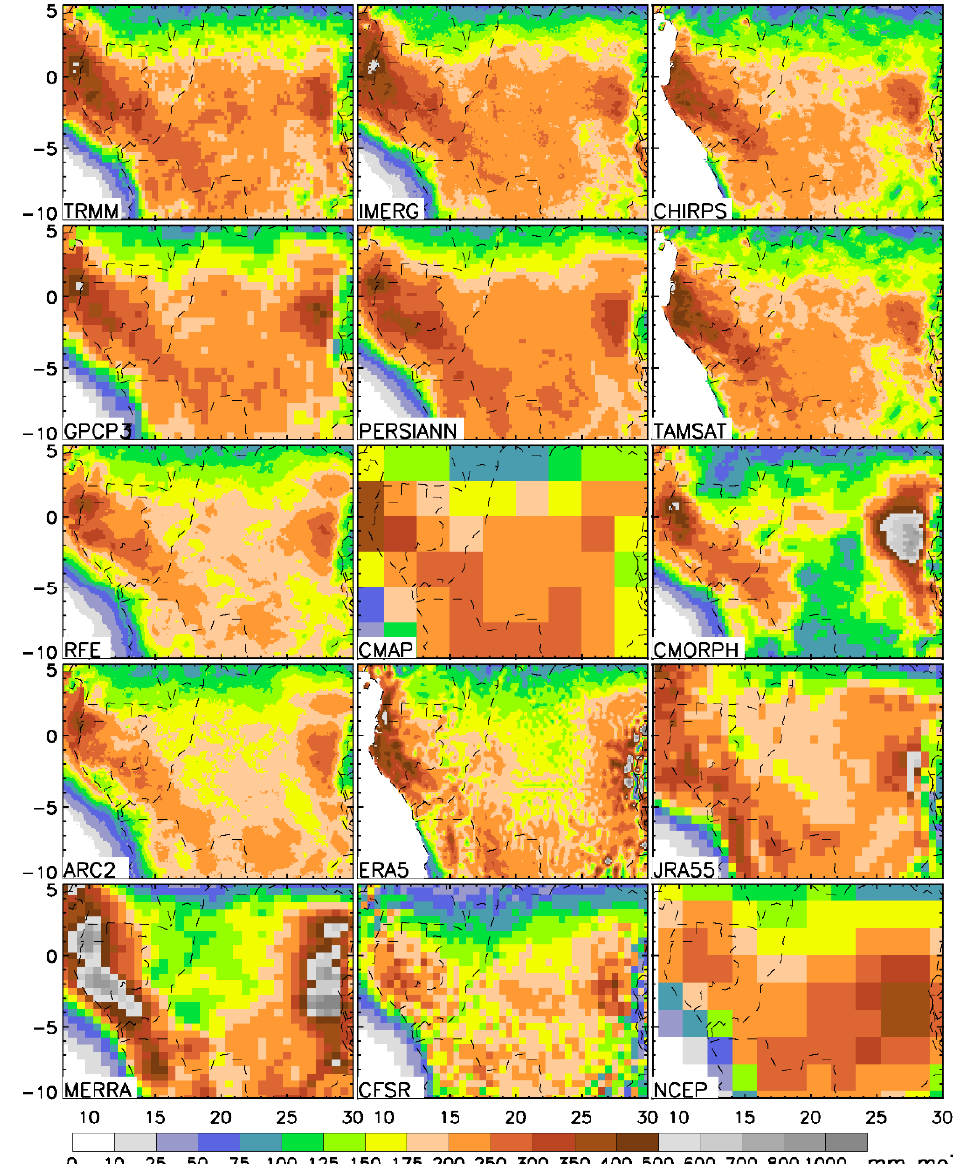
Figure 7. Mean November rainfall (2001–2019) over the Congo region from fifteen satellite and reanalysis products.